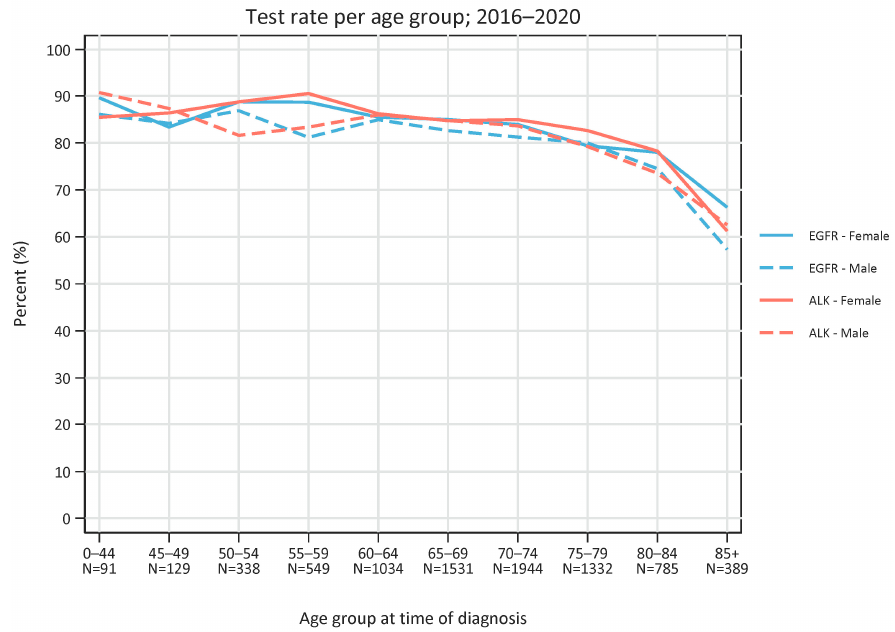
Figure 1. Test rate (number of tests versus number of diagnosed non-squamous non-small cell lung cancer patients) and fraction of positive tests per year in the period 2013–2020. Left panel represents EGFR tests and right panel represents ALK tests.